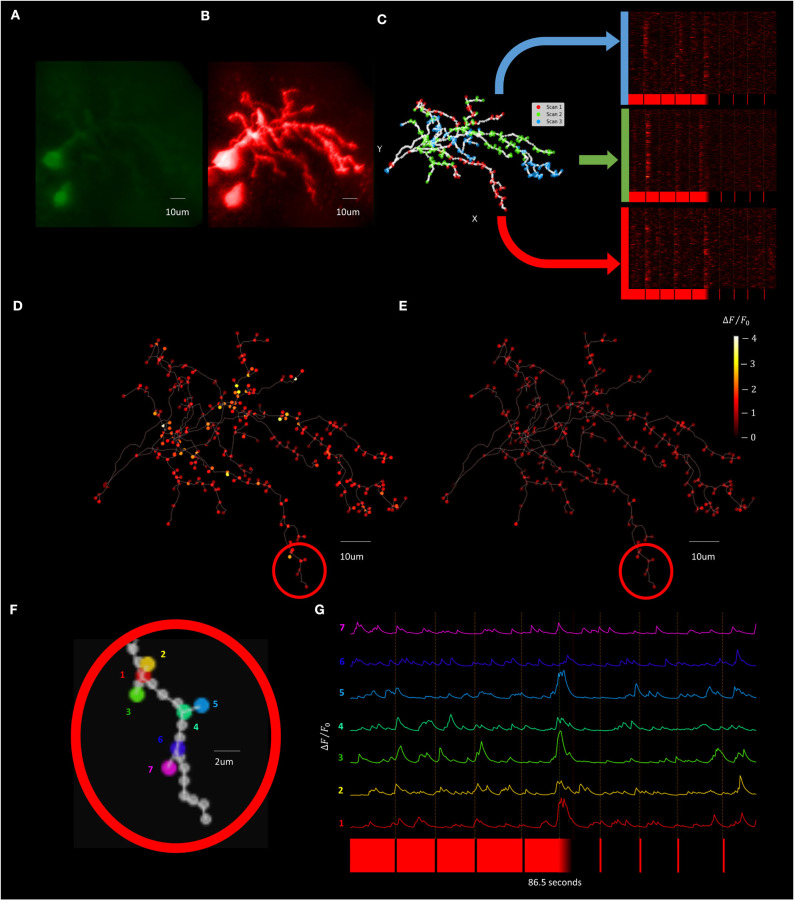
Visually evoked synaptic calcium transients across the neuron can be recorded with increased temporal resolution using Segmented Scanning. (A,B) A standard deviation projection image in the green (A) and red channels (B) of a Xenopus tectal neuron expressing jGCaMP7s and mCyRFP created from a F3DS stack of images is shown. (C) The user-drawn POIs tracing out the structure of the neuron with the POIs that are sampled in each sub-scan of the Segmented scan are colored and the subsequent visually evoked calcium activity is shown. A total of 324 POIs located at the soma, branch points, filopodia bases and tips are collected at a rate of 6 Hz. (D,E) The maximum of the average ΔF/F0 evoked responses for both a series of four pseudorandom 50 ms “OFF” (D) and four 50 ms “ON” stimuli (E). (F) A series of POIs recorded corresponding to filopodia tips and bases and (G) the individual calcium traces of those POIs.